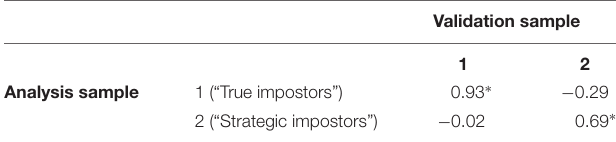
TABLE 4 | Correlation matrix between the two-cluster solutions.